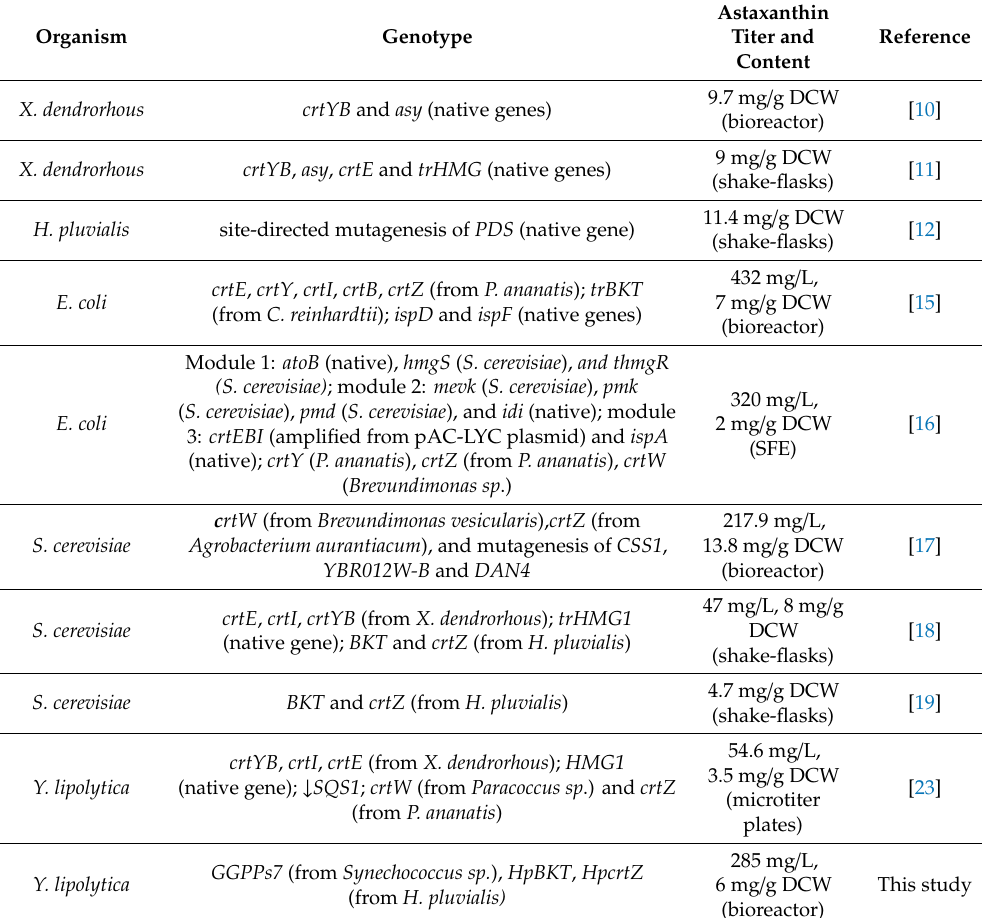
Table 1. Summary of astaxanthin production by natural producers and engineered non-carotenogenic organisms. Single black arrow ( ↓ ) represents